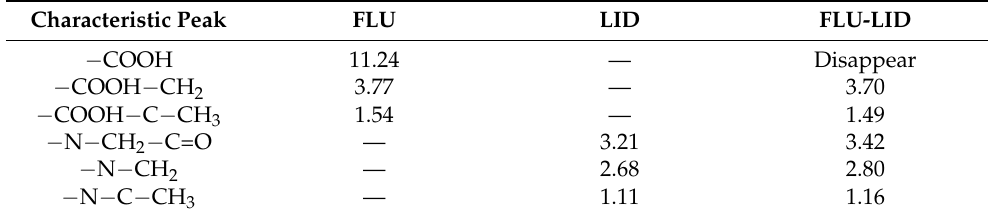
Figure 2. ( a ) Glass transition temperatures ( T g ) of IL; ( b ) FTIR spectra of FLU, LID, and FLU − LID. Table 1. 1 H NMR data of FLU, LID and FLU-LID ILs (Chemical shift, ppm). Characteristic